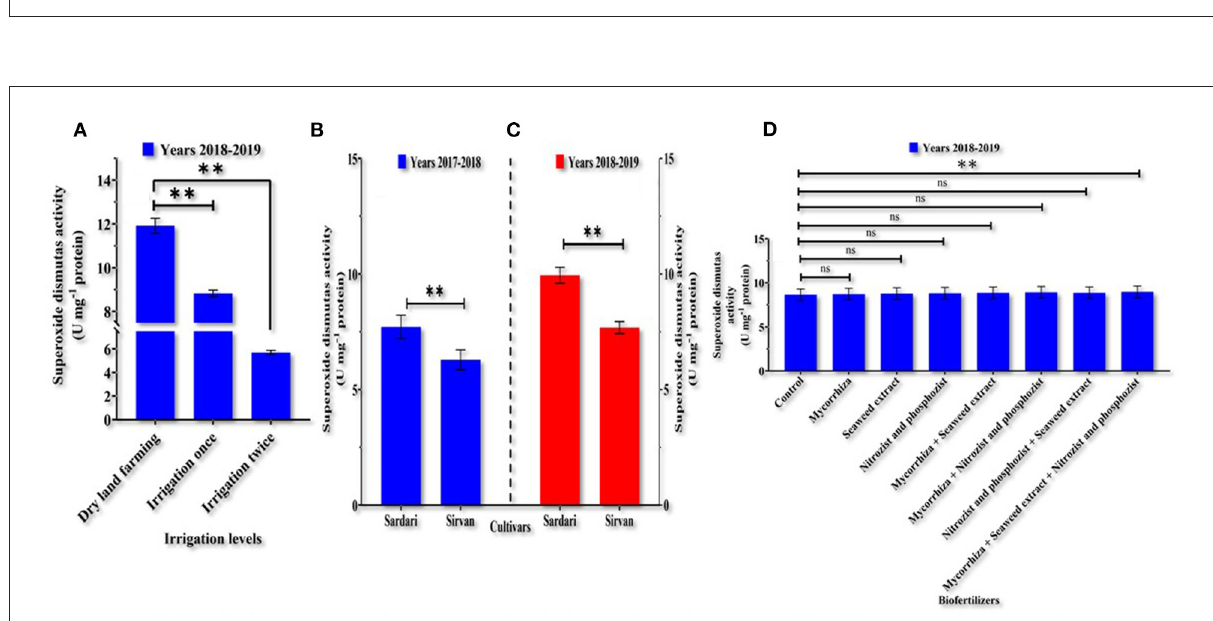
FIGURE3 Mean comparisons of main effects of irrigation levels (A) on malondialdehyde (2018–2019), main effects of cultivars (B,C) in the years 2017–2018 and 2018–2019, and bio-fertilizers (D) in the year 2018–2019 on superoxide dismutase activity in the wheat plant. At p > 0.05, ns, not significant; and **0.001 < p ≤ 0.01.